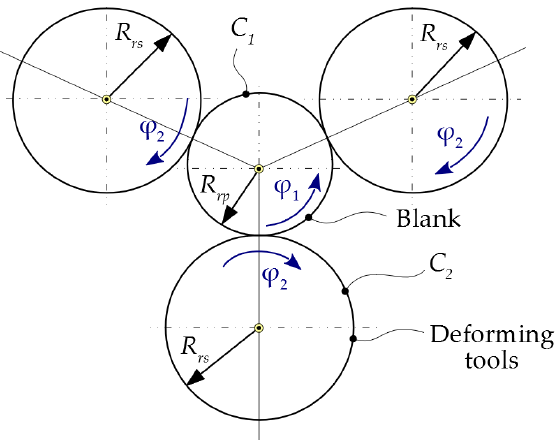
Figure 1. Generating principle. Rolling centrodes: C 1 ; C 2 . C 1 —the centrode of the blank, having the radius R rp , and C 2 —the centrode of the tool of radius R rs .